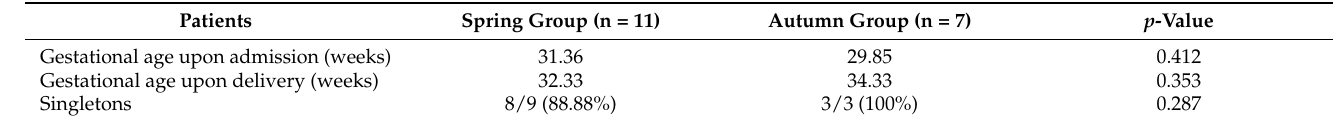
Table 1. Description of the pregnant population in the two groups: mean values.